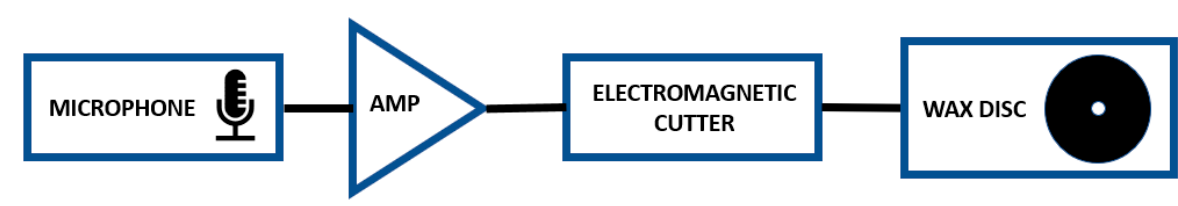
Figure 9. LSN recording system diagram.